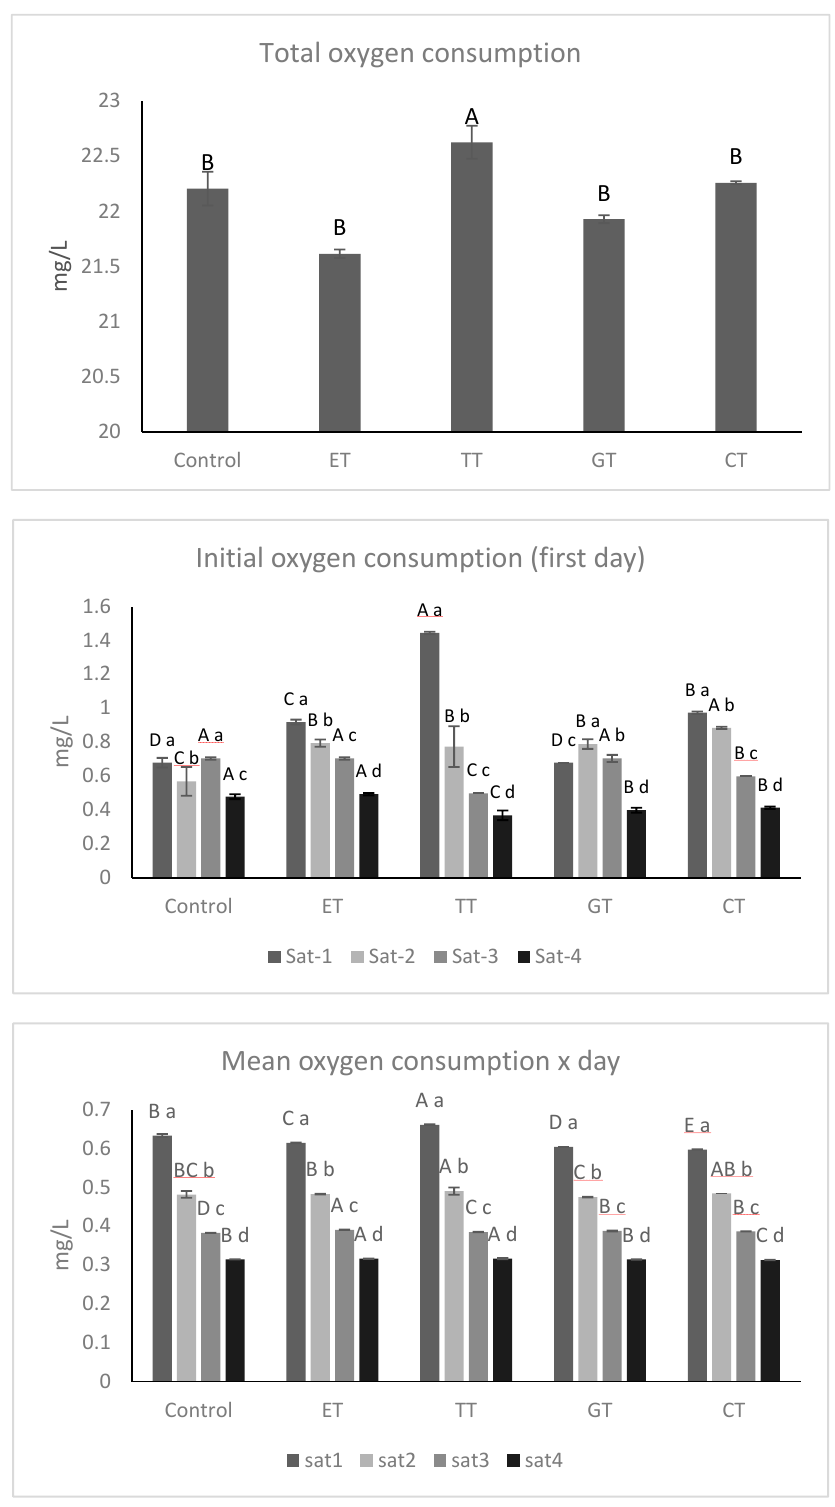
Figure 2. ( A ) Total oxygen consumption; ( B ) initial oxygen consumption rate on the first day; ( C ) mean oxygen consumption rate per day for each saturation cycle. All the data are expressed as means ± standard deviation. Di ff erent letters indicate a statistically significant di ff erence among treated wines during each saturation time (A, B, C, D, E) and among treated wines for the same saturation time (a, b, c, d). All the data are expressed as means ± standard deviation, ( p <